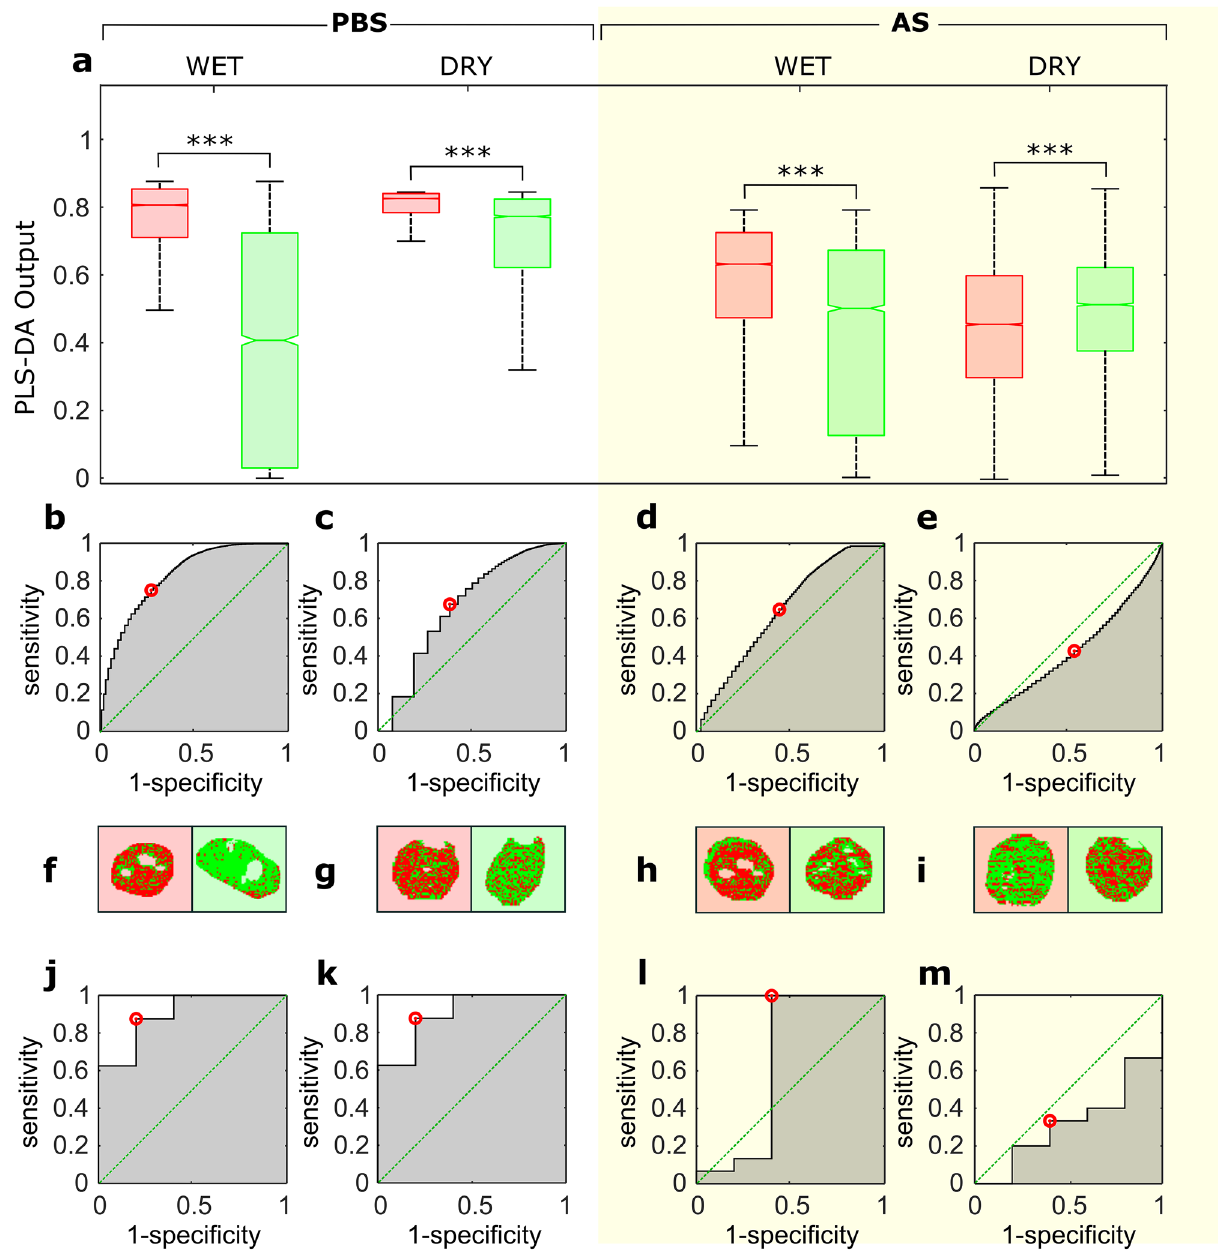
Figure 3. Classification of VSV-G pseudotyped lentiviral particles using PLS-DA. ( a ) median value of the PLS-DA output used for pixel classification for wet and dry samples prepared in phosphate buffer solution (PBS) and artificial saliva (AS). The boxes represent the interquartile range, and the whiskers show 2.7 times the standard deviation. Lentiviral particles (LP), denoted here in red, were prepared in PBS (LP-PBS) or in artificial saliva (LP-AS). Negative controls, represented here in green, were prepared from non-transfected culture media in PBS (PBS-control) or in artificial saliva (AS-control). *** p-value < 0.0001 from two-tailed Wilcoxon rank-sum test. ( b ) ROC curve obtained from the pixel classification of LP-PBS. ( c ) ROC curve from the pixel classification of LP-PBS obtained after complete evaporation of the water content. ( d ) ROC curve obtained from the pixel classification of LP-AS. ( e ) ROC curve from the pixel classification of LP-AS obtained after complete evaporation of the water content. ( f–i) example of a pixel classification in a droplet. Red and green pixels denote pixels classified as positive and negative respectively. Note red and green backgrounds indicate positive droplet and its negative control respectively. ( f ) LP-PBS. ( g ) LP-PBS dry residue. ( h ) LP-AS. ( i ) LP-AS dry residue. ( j ) ROC curve obtained from droplet classification of LP-PBS. ( k ) ROC curve from droplet classification of LP-PBS obtained after complete evaporation of the water content. ( l ) ROC curve obtained from droplet classification of LP-AS. ( m ) ROC curve from droplet classification of LP-AS obtained after complete evaporation of the water